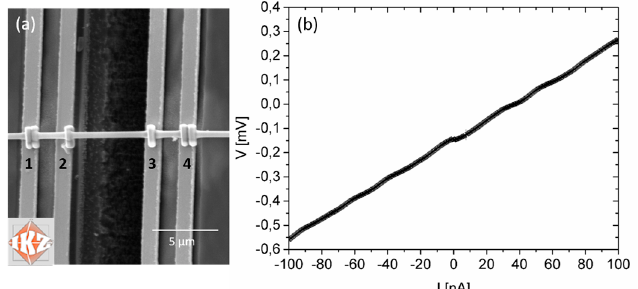
Figure 2. ( a ) SEM picture of a Bi 2 Te 3 nanowire placed on the TNCP, and attached and electrically connected by means of the FEBID technique. ( b ) I-V curve of a Bi 2 Te 3 nanowire at T = 285 K as base temperature. The linear trend shows an ohmic